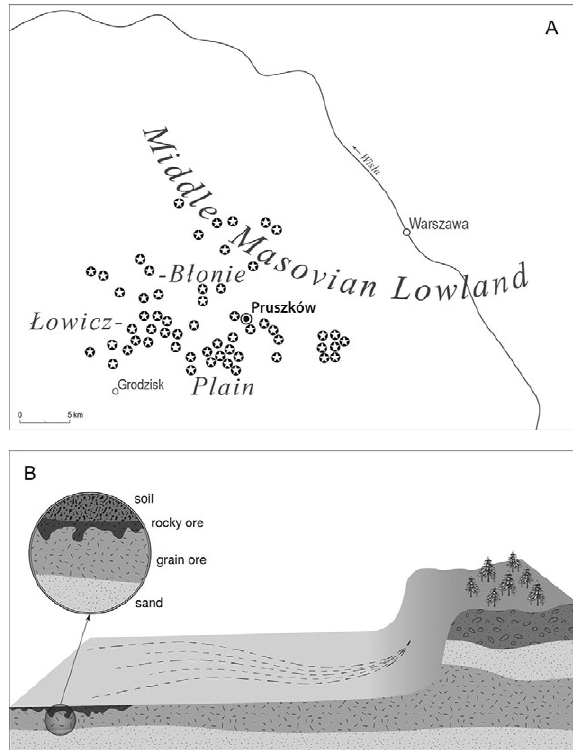
Fig. 3. A: Ancient Mazovian metallurgy in the vicinity of Pruszków – archaeological sites are marked. b: Formation of bog iron ore. Source: Rutkowski (2001), modified.